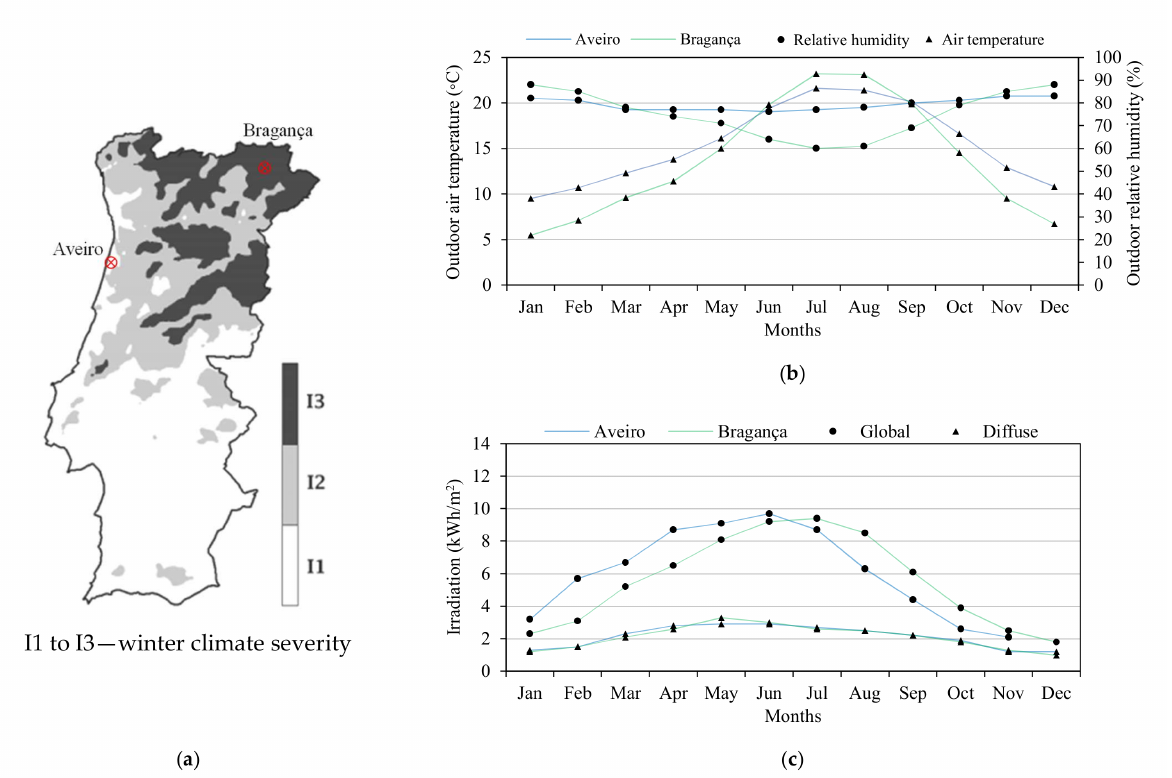
Figure 3. Climate information for Bragança and Aveiro: ( a ) winter map classification; ( b ) outdoor monthly average air temperature and relative humidity [40]; and ( c ) monthly average daily solar horizontal irradiation